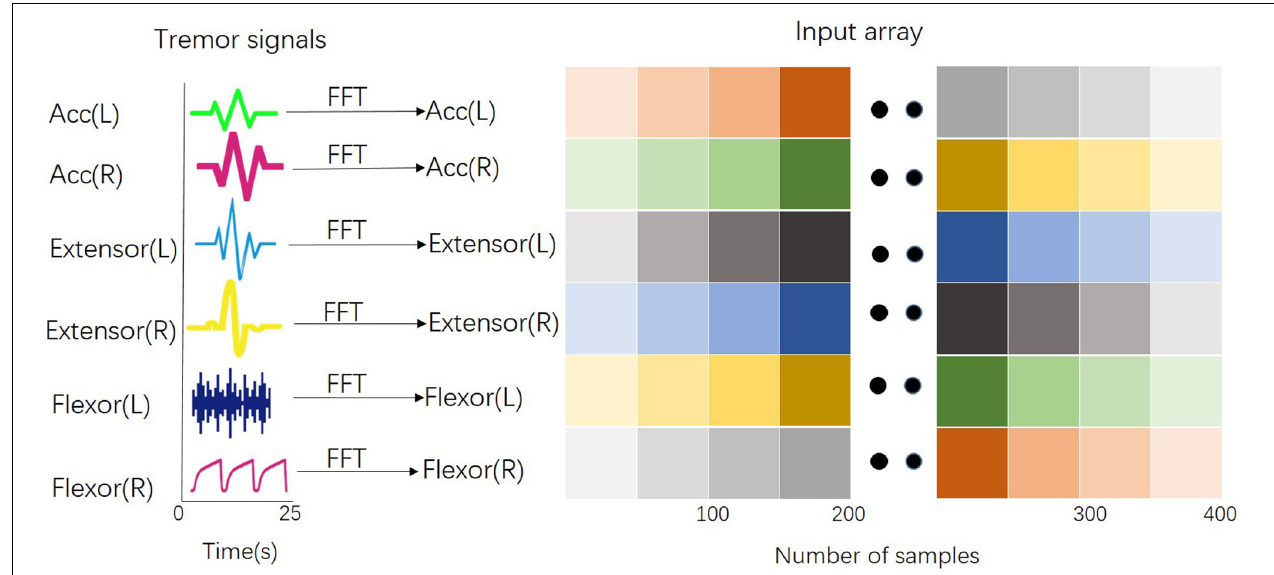
FIGURE 2 | Input array for the training of the CNN model. All signals from the acceleration measurement and sEMG measurement have been converted into the frequency domain by the Fast Fourier Transform and stacked along the vertical axis to form a two-dimensional array for CNN input.